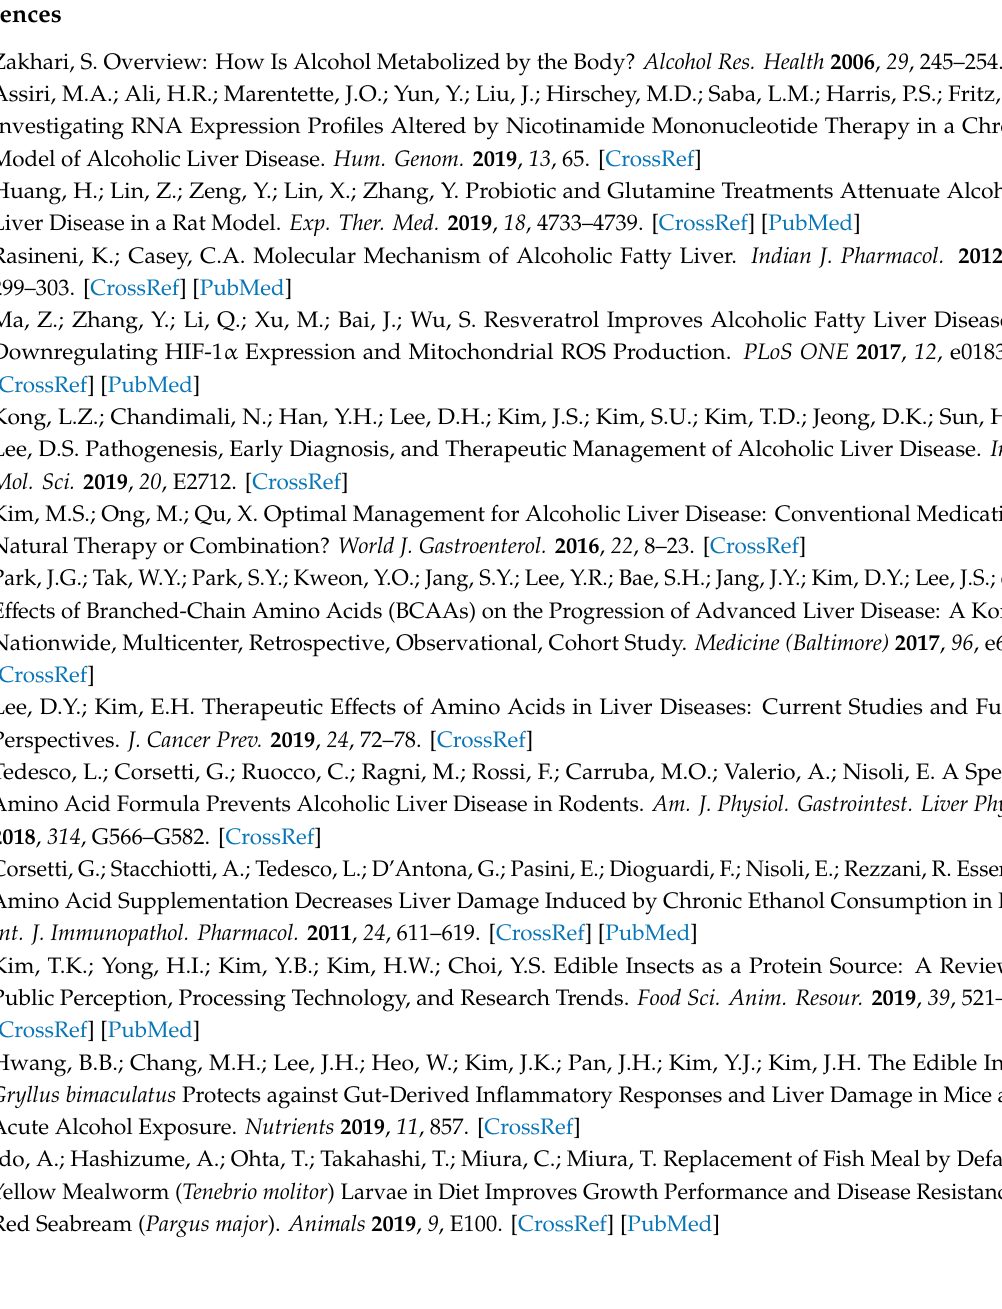
Table S1: Composition of the control and alcohol liquid diets, Table S2: E ff ects of MWF on the body weight, food intake, serum marker levels, and lipid contents in chronic alcohol-fed rats, Table S3: E ff ects of MWF on the richness and diversity of the bacterial community deduced by 16S rDNA profiling in chronic alcohol-fed rats Author Contributions: Conceptualization, R.-Y.C. and M.-K.L.; Validation, S.S.L., M.-J.P., K.-W.P., and H.-I.L.; Formal analysis and Investigation, R.-Y.C., J.R.H., H.-S.R., M.A.M., M.J., and K.-Y.K.; Writing–Original